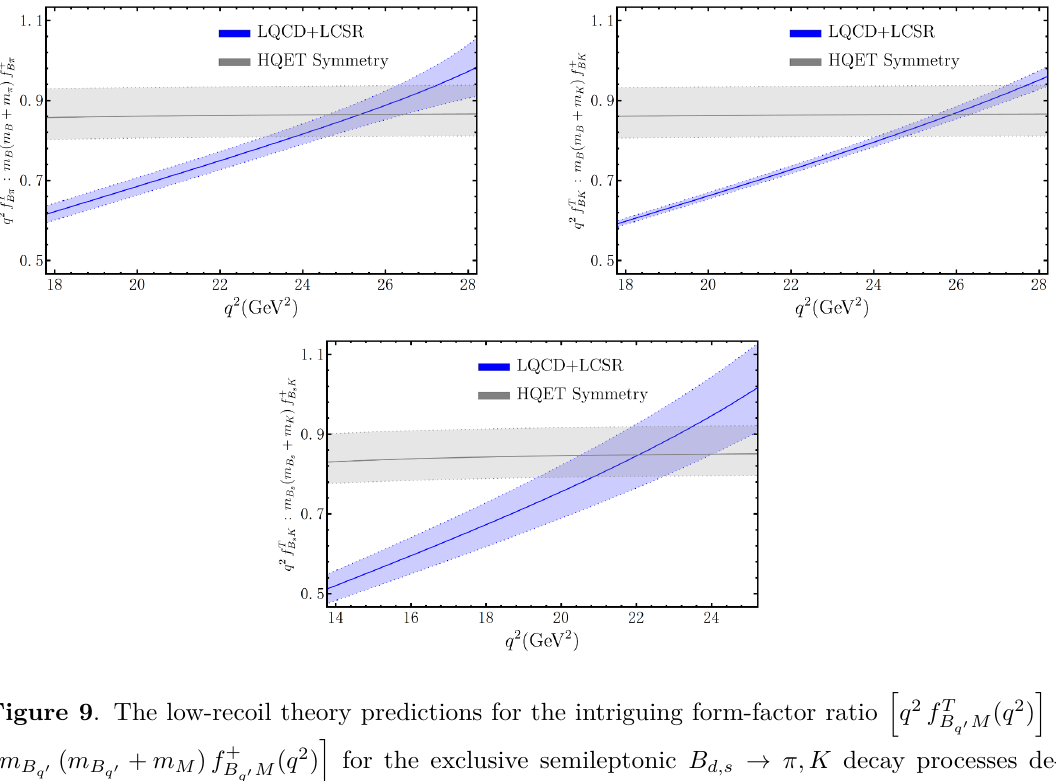
Figure 9 . The low-recoil theory predictions for the intriguing form-factor ratio h i ( m + m ) f + ( q 2 ) for the exclusive semileptonic B m B B q 0 M B q 0 M q 0 termined from the combined BCL z -series expansion fitting against both the LCSR and lattice QCD data points (blue bands) and from the theoretical expectations of the improved Isgur-Wise relation (4.39) at the NLP accuracy due to the combination of heavy quark and chiral symmetries (grey bands) [156,